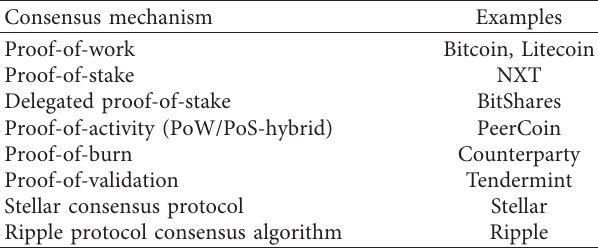
Table 4: Various consensus mechanisms.